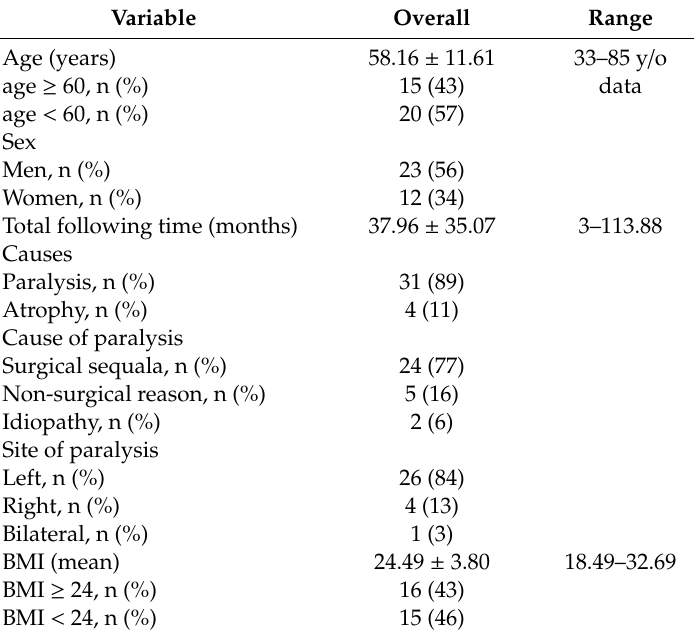
Table 1. Patient